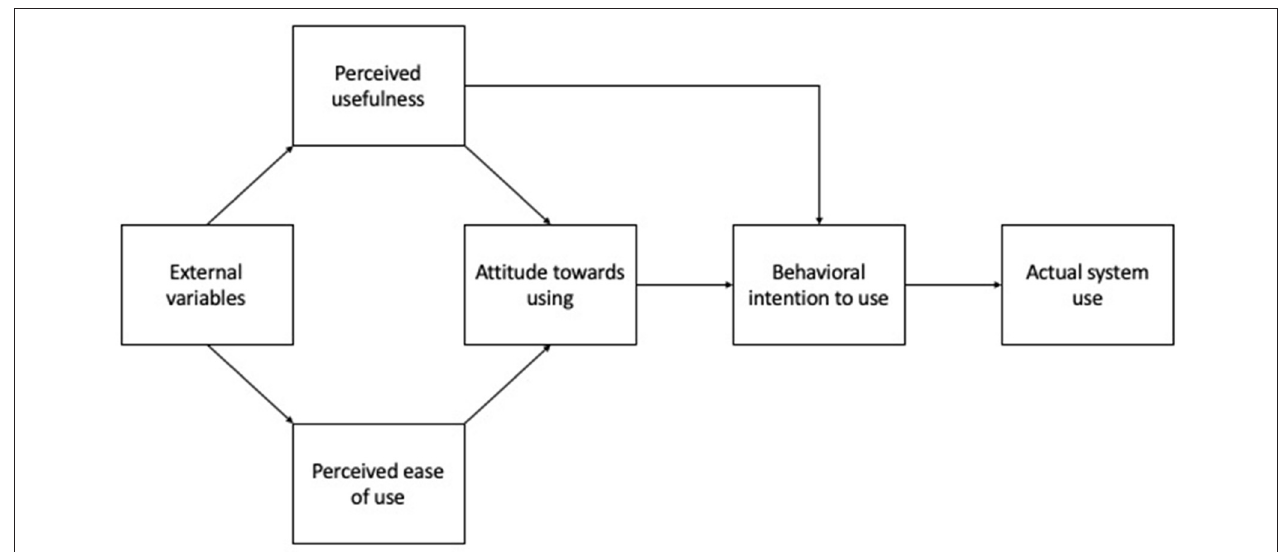
FIGURE 1 | Technology acceptance model (24,